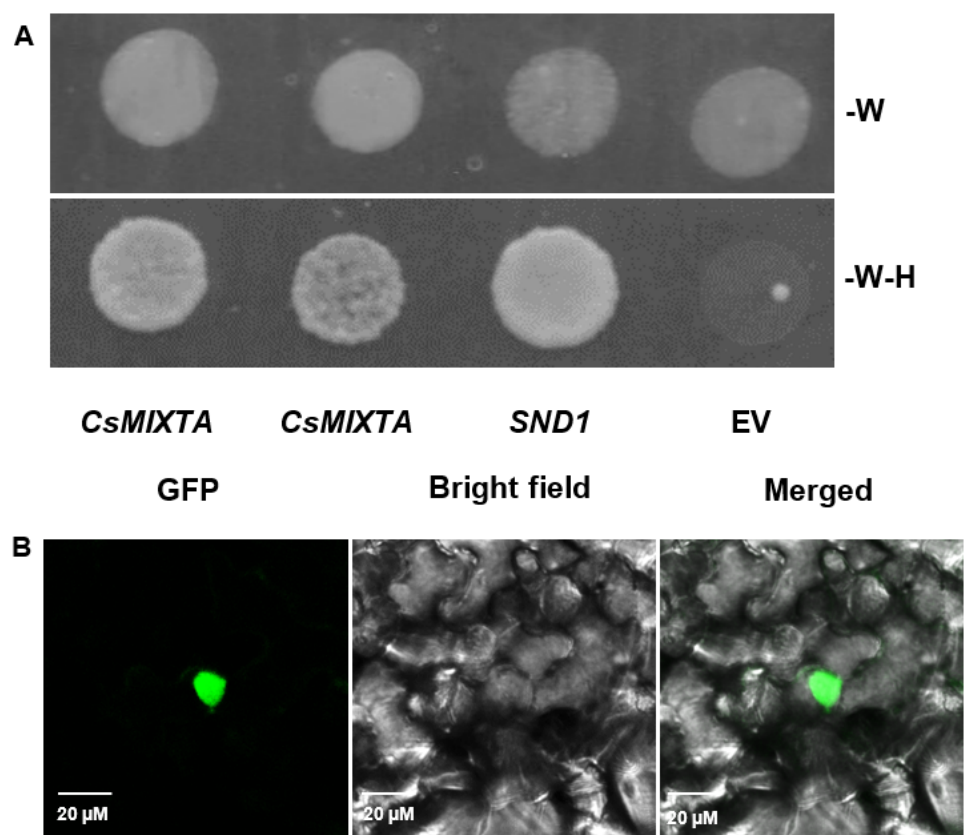
Figure 2. Yeast transactivation assay and subcellular localization of CsMIXTA. ( A ) Top: yeast cells grown on SD medium lacking W. All cells grew normally, including cells transformed with the empty vector (EV). Bottom: yeast cells grown on SD medium lacking tryptophan (W) and histidine (H). Cells expressing CsMIXTA produced healthy cultures, while pAS2 empty vector transformed culture did not. ( B ) N. benthamiana epidermal cells expressing a CsMIXTA-YFP fusion protein, observed using Nikon A1R Confocal microscope with excitation at 488 nm. YFP signal clearly indicates nuclear localization.